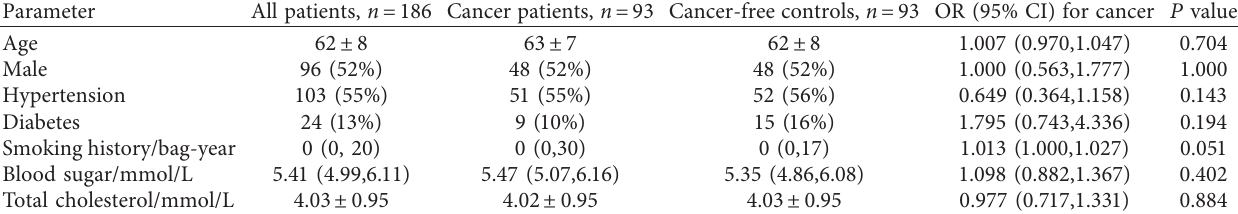
Table 2: Basic characteristics of patients matched by gender and